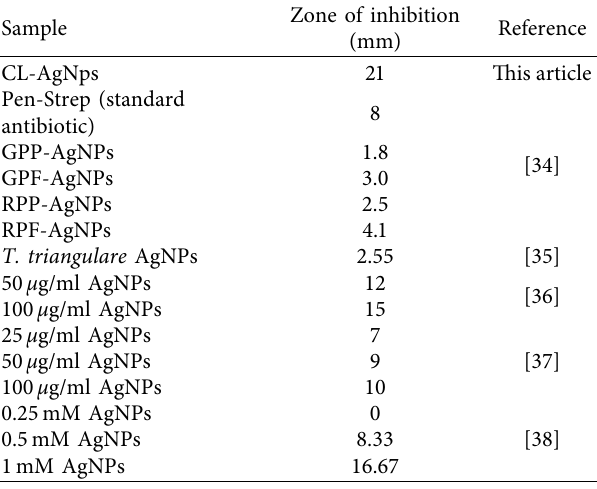
Figure 6: (a) Zone of exhibition of antimicrobial activity. (b) Optical microscope image of the zone of exhibition of CL-AgNPs. Table 1: Zones of inhibition of green synthesized AgNPs against E. coli